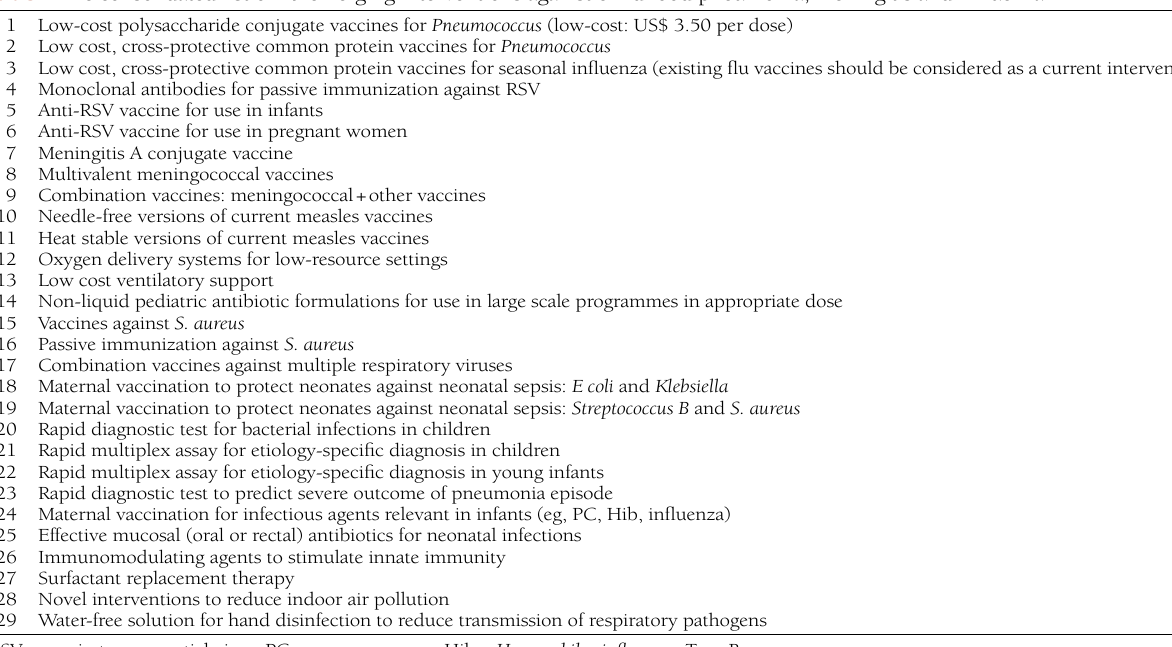
Table 1 The consolidated list of 29 emerging interventions against childhood pneumonia, meningitis and